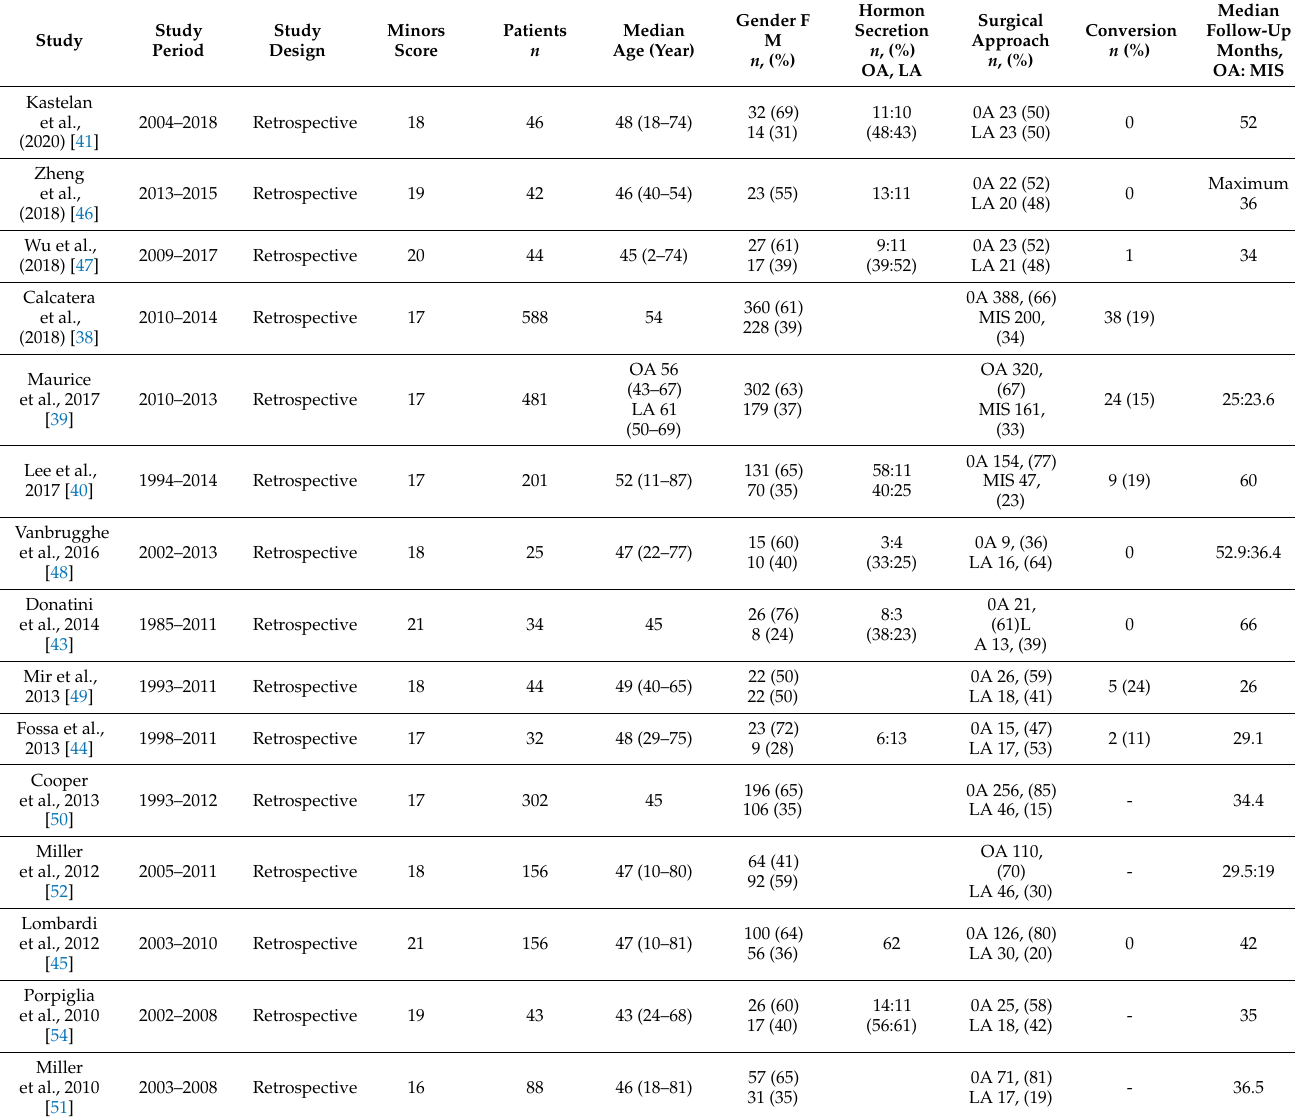
Table 2. Characteristics of the